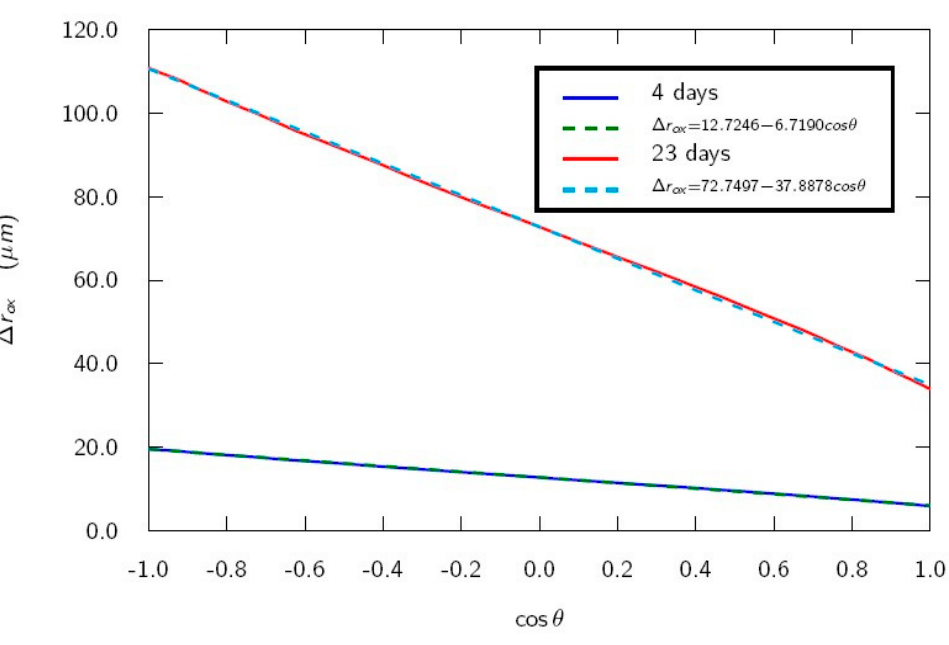
Figure 6. Di ff erence of oxide radius with respect to the initial radius versus cos θ after four days and Figure 6. Difference of oxide radius with respect to the initial radius versus cos q after four days 23 days of and 23 days of corrosion.